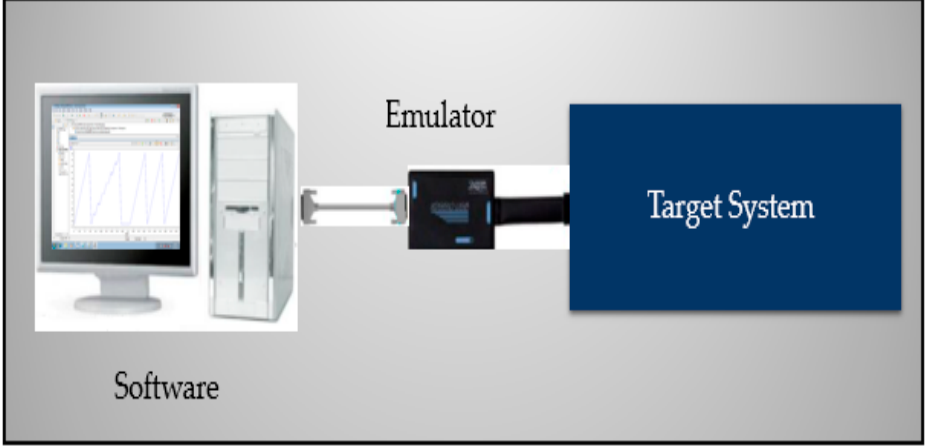
Figure 8. Emulator environment .